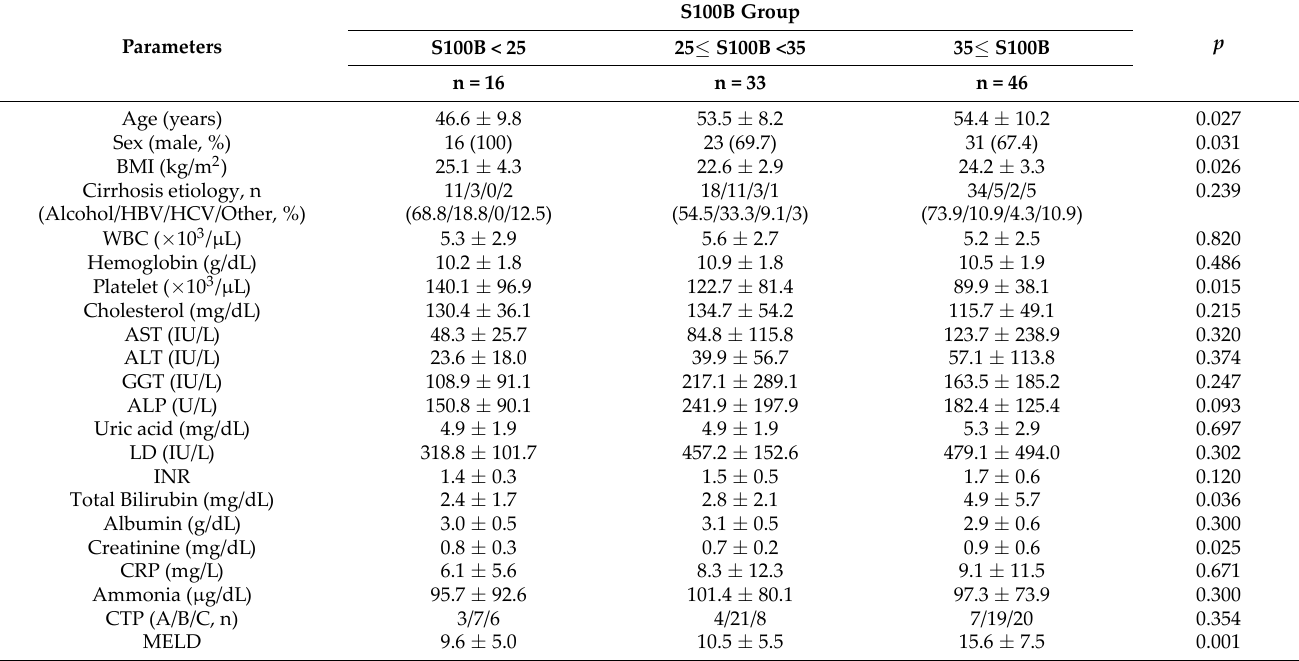
Table 3. Clinical characteristics of the patients according to serum S100B